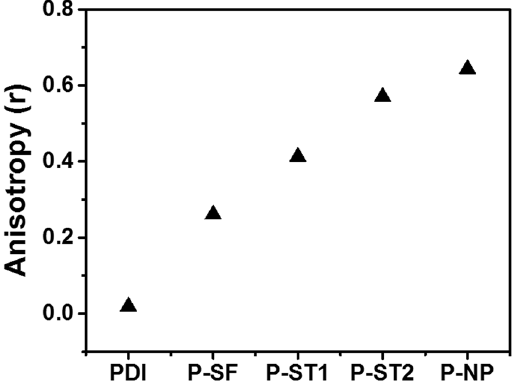
Figure 4. Fluorescence anisotropy (r) of PDI molecule, P-SF , P-ST1 , P-ST2 nanoparticles dispersed in THF and P-NP nanoparticles in water.